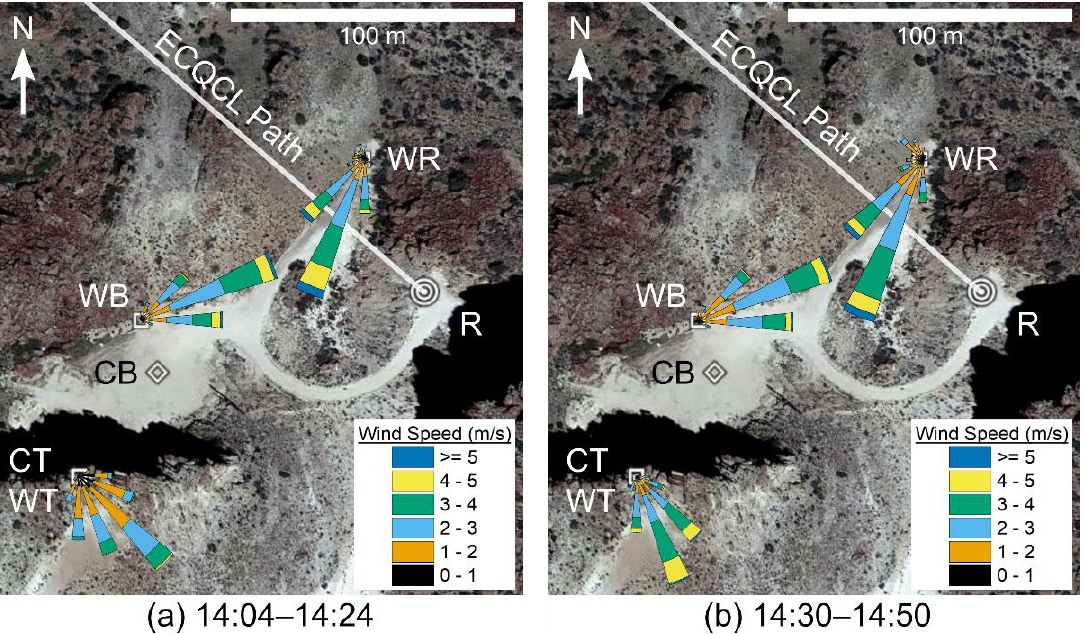
Figure 4. Wind rose plots showing horizontal direction/speeds at ~2-m above ground level over time periods (local time hh:mm) ( a ) 14:04 – 14:24 and ( b ) 14:30 – 14:50, overlaid on an image from Google Earth. Labels are defined in Figure 2a.